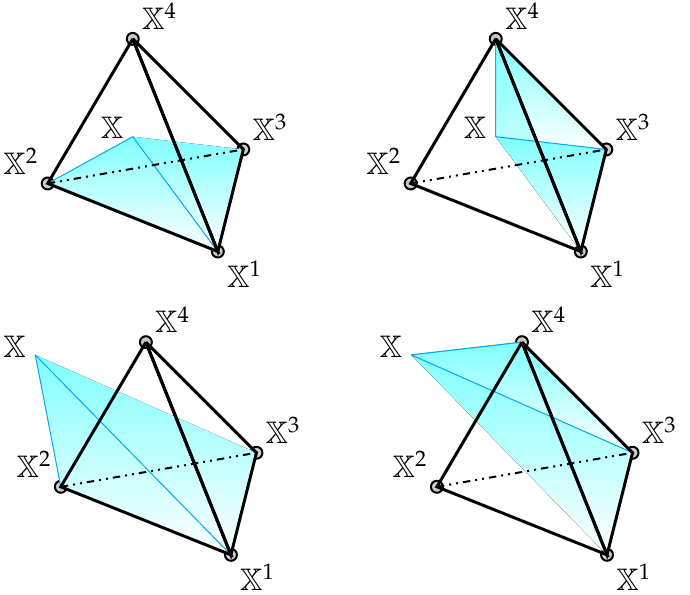
Figure 2. Examples of partitioned volumes V I associated with point X : ( top ) two figures illustrate two volumes for point inside the tetrahedron; ( bottom ) two figures illustrate two volumes for a point outside the tetrahedron.